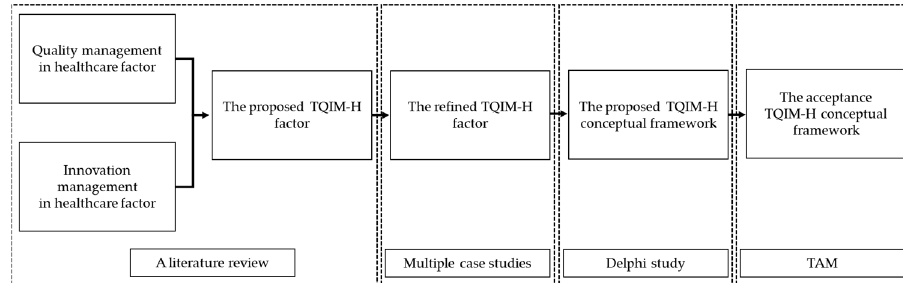
Figure 1. The concept to develop TQIM-H .